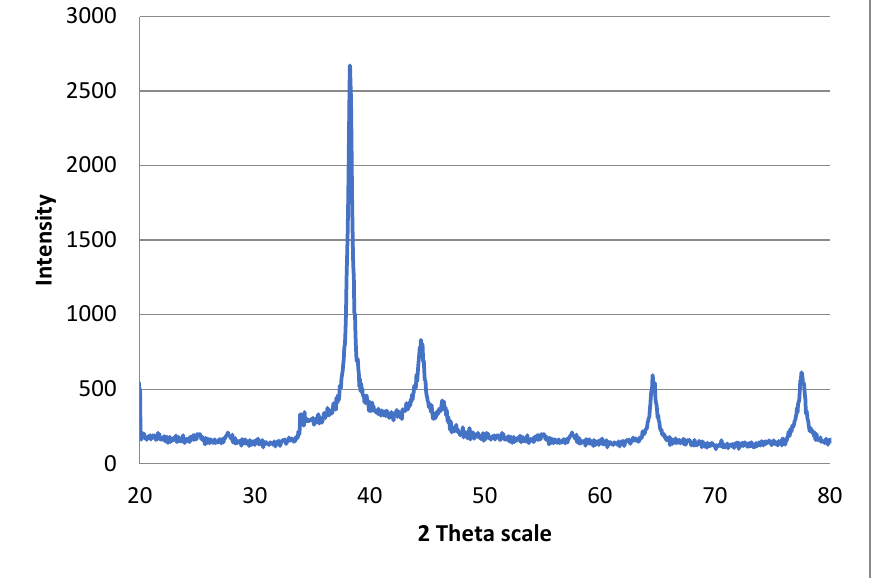
Figure 3. X-ray diffraction (XRD) spectra of AgNPs produced with Ulvan from Ulva lactuca .